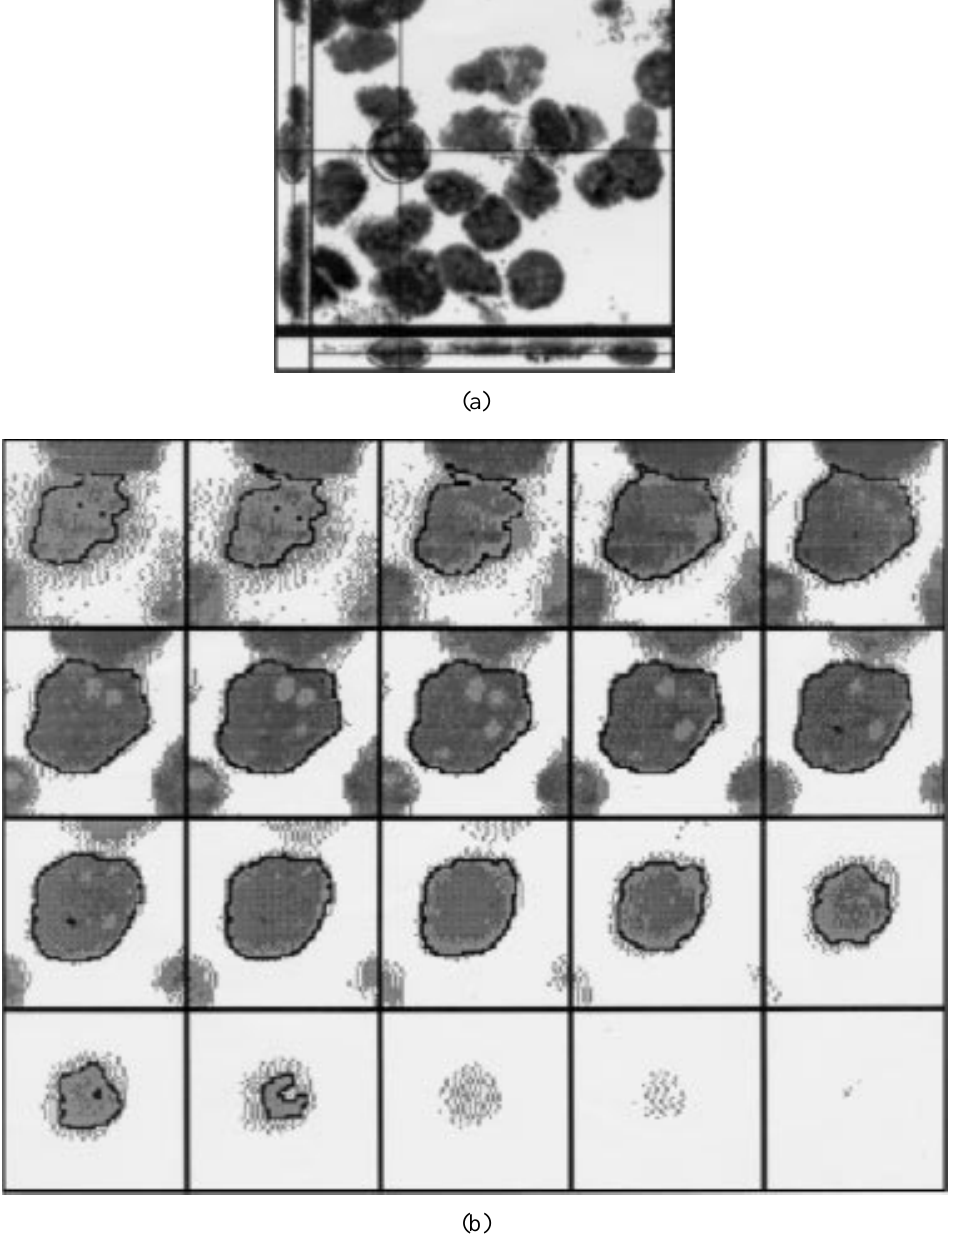
Fig. 6. Results of segmentation of tissue by deformable models. (a) Initialization shown over one XY , Y Z and XZ planes of the image stack. (b) Sequence of images in the stack showing the result of optimization of the deformable elipsoid. the signal; (vi) number of intensity peaks within the nal is due to its three-dimensional nature. Consider- signal, etc. An appropriate maximum and minimum ing the excellent axial resolution of the image stack, only those signals that occupy a minimum of two im- size threshold for the signal are determined experimen- age slices in a continuum are considered as FISH sig- tally. Only those signals that fall within the size are considered for further processing. The shape of the sig- nals subject to other conditions. A threshold for